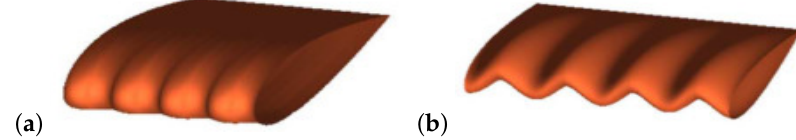
Figure 6. Two forms of the modified NACA 0021 airfoils, reprinted from [72] with permission from AIP Publishing: ( a ) the chord changed sinusoidally in the spanwise direction; and ( b ) the geometric angle of attack varied sinusoidally along the